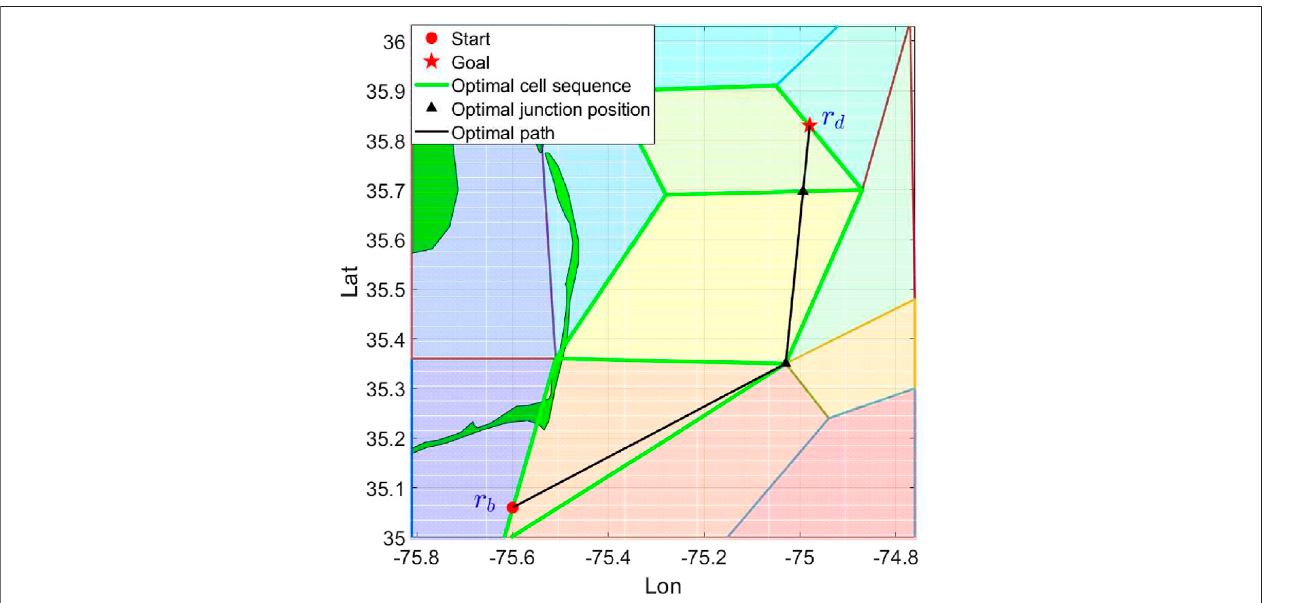
FIGURE 7 | Example of simulation case. The resulting path is computed by the proposed method.